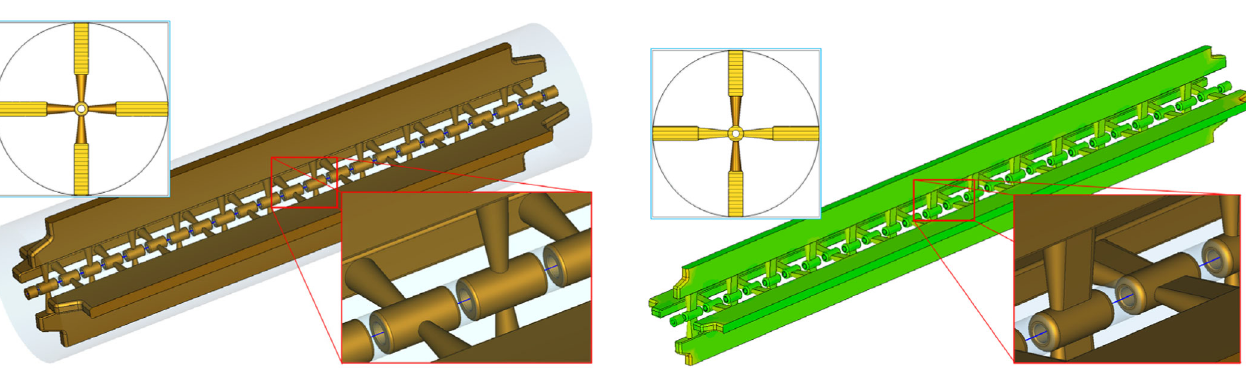
FIG. 25. MWS model of the CH tank for 5.4-MeV protons with the outer wall removed.